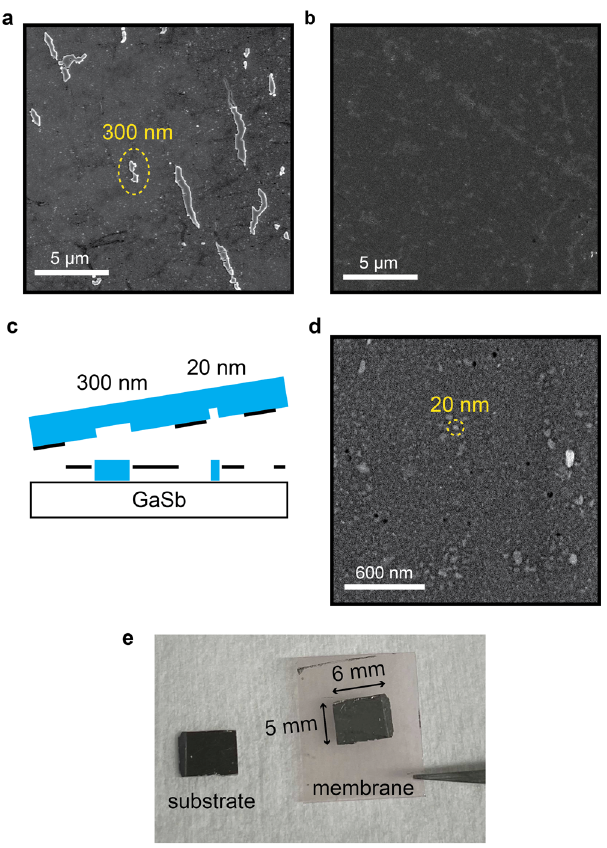
Fig. 5 Exfoliation of GaSb membranes that are seeded at pinholes. a SEM image of the substrate after exfoliation, showing ~300 nm diameter spalling marks and clusters of spalling marks. b SEM image of the substrate showing a relatively smooth region with no large spalling marks. c Cartoon of the exfoliation. d Magni fi ed SEM image of the substrate showing ~20 nm spalling marks. e Photograph of the substrate and the exfoliated GaSb membrane supported on thermal release tape. The lateral dimensions of the membrane are 5 mm by 6 mm.